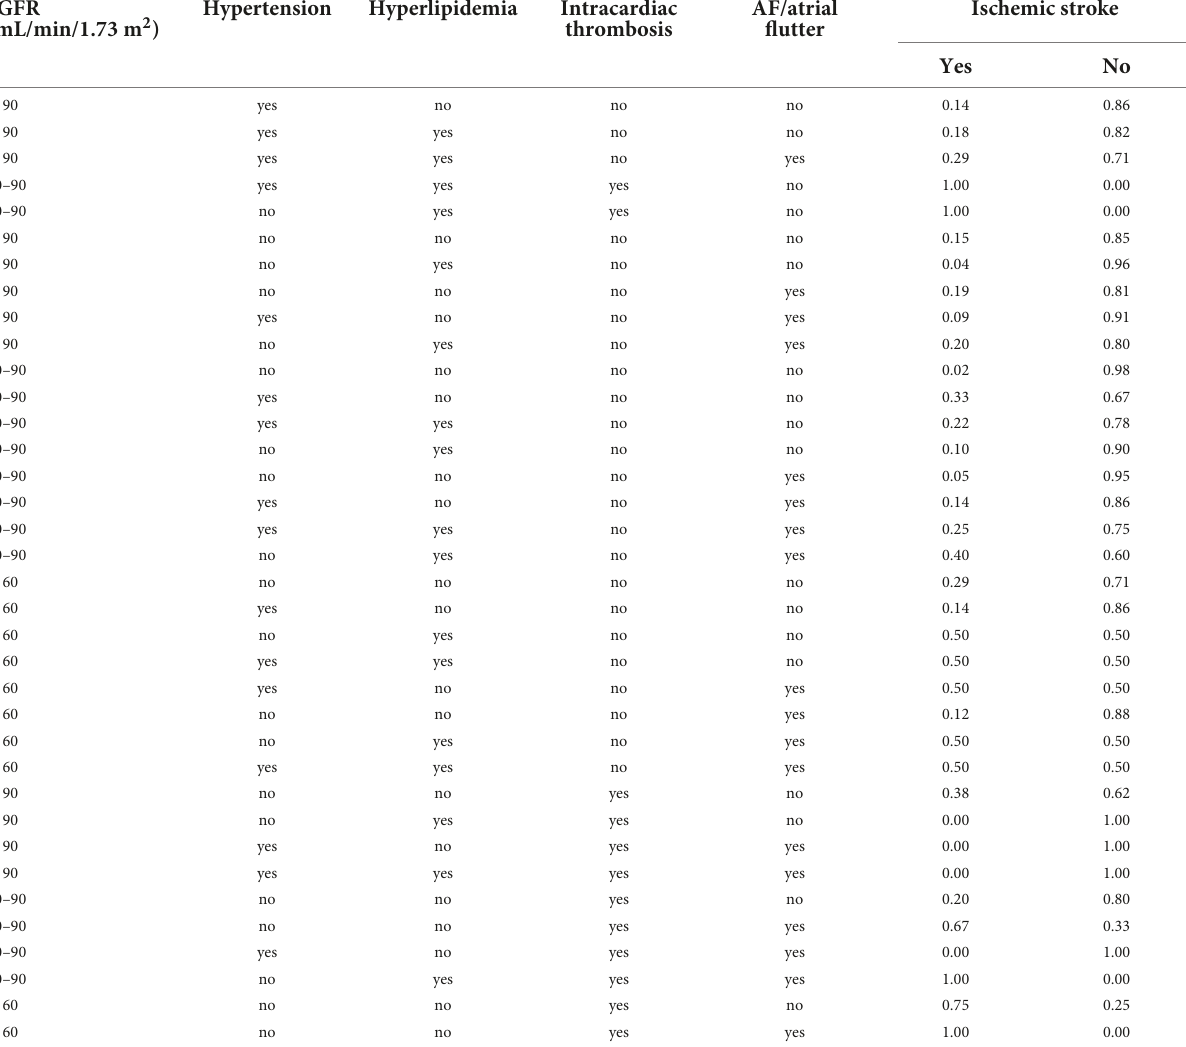
TABLE 3 The conditional probability table of the training set basing on ischemic stroke (IS) as the target node. eGFR Hypertension Hyperlipidemia Intracardiac (mL/min/1.73 m 2 )